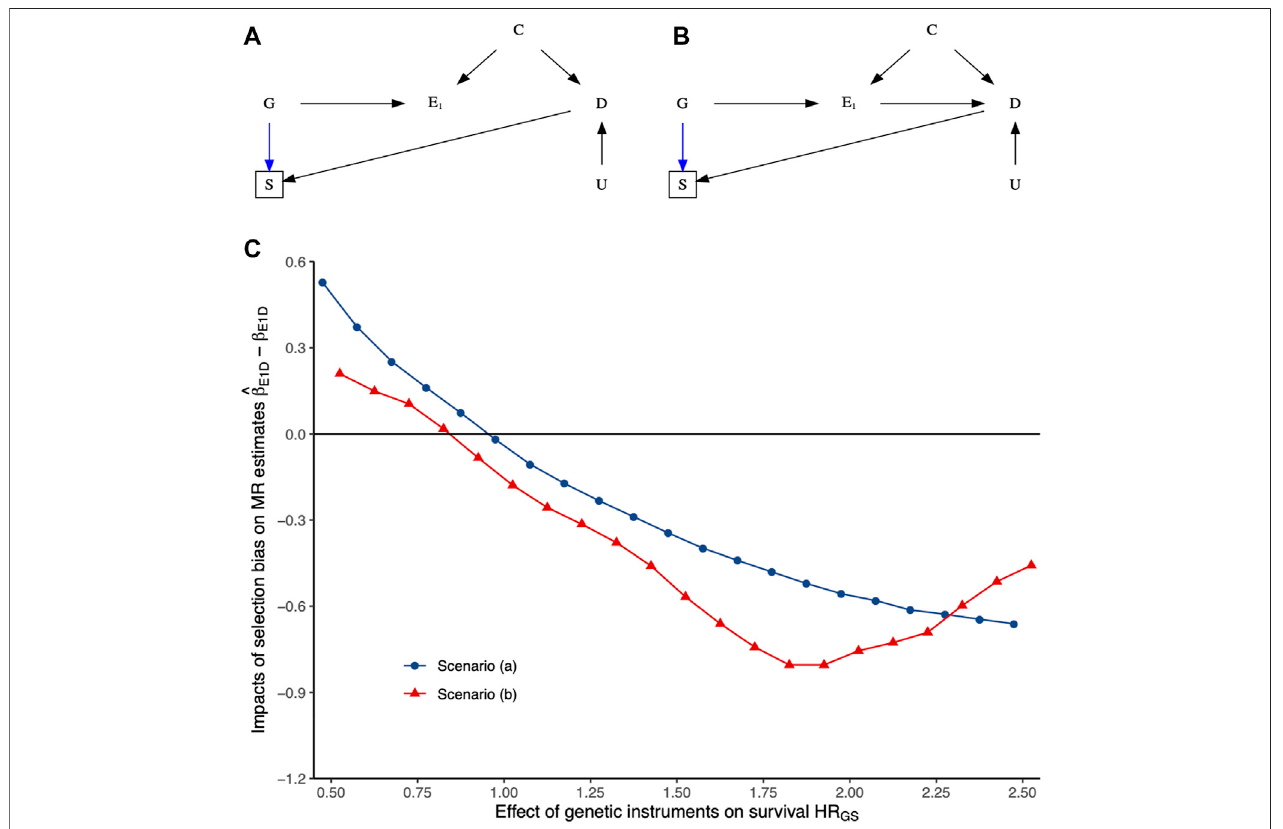
FIGURE 3 | The impacts of selection bias (i.e., ^ β E 1 D − β E 1 D ) on two-sample Mendelian randomization (MR) estimates of the exposure E 1 – outcome D association using the inverse-variance weighted method in terms of various relative hazards (HRs) of per-unit change in genetic instruments G (i.e., HR GS ) with a fi xed effect of D (i.e.,HR DS )onsurvivalofunderlyingpopulationbasedonsimulationstudies,withmoredetailspresentedin SupplementaryMaterialS1 .Theupperpanels (A,B) show scenarios that may happen in practice. The lower panel (C) shows the impacts of selection bias on MR estimates under each scenario. R codes for reproducing these results can be found in Supplementary Material S2